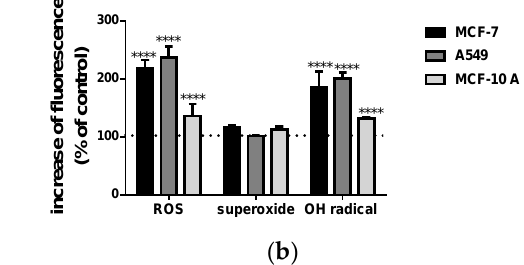
Figure 9. ( a ) Relative ROS, and ( b ) O 2 • - concentration in MCF-7 cells loaded with Fe 3 O 4 NPs, AuNC or Fe 3 O 4 @Au pNPs which were exposed to X-radiation at a single dose of 1 Gy or left non-irradiated (n = 6, *p < 0.05, ***p < 0.001, ****p < 0.0001).